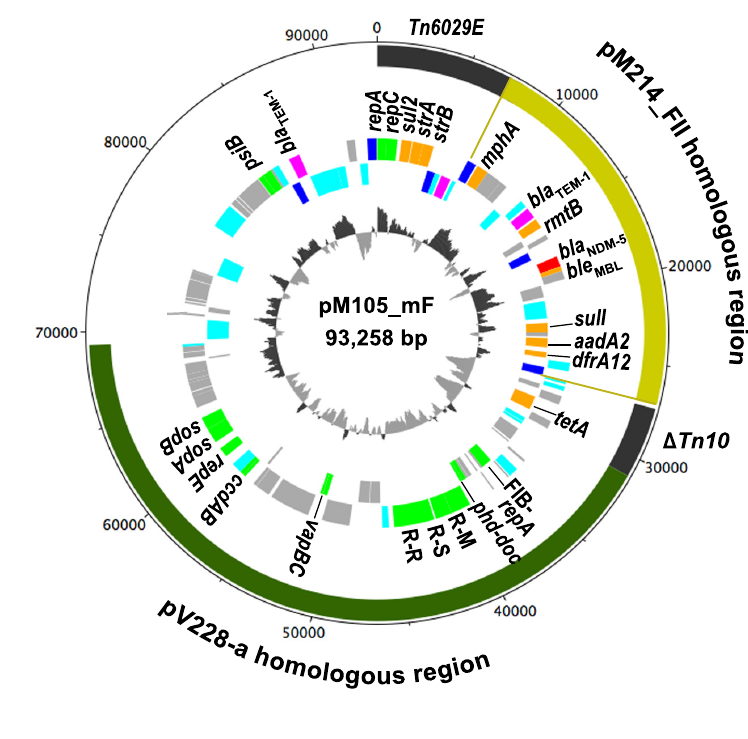
Fig 5. Circular map of plasmid pM105_mF. The outermost circle indicatessize in bp. The next circle indicatescomposite transposons (dark gray) and regions homologous to the bla NDM-5 regionin pM214_FII (yellow)and pV228-a(dark green). The third and fourth circles show codingsequencestranscribed clockwise and anti-clockwise, respectively. Genes are indicatedin colors as definedin Fig 2, except that genesinvolved in plasmidreplicationand maintenance are illustrated in green. R-M, R-S, and R-R denoterestriction- modificationgenes(M, methylase; S, specificity; and R, restriction). The innermost circle shows GC content.